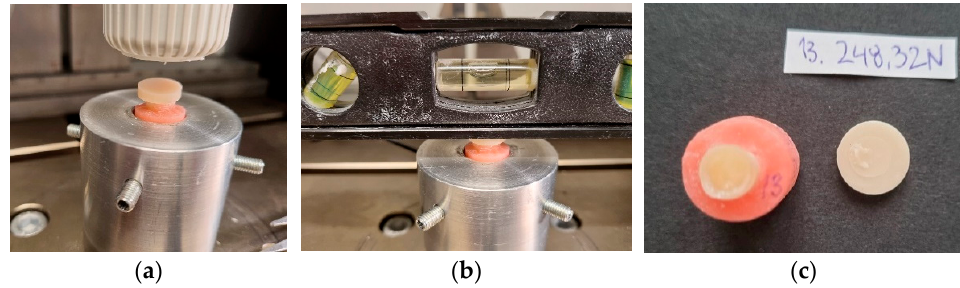
Figure 5. Tensile bond strength test. ( a ) Specimen adapted in a holder; ( b ) The specimen levelled and passed selection; ( c ) Specimen after the test and for failure mode analysis.